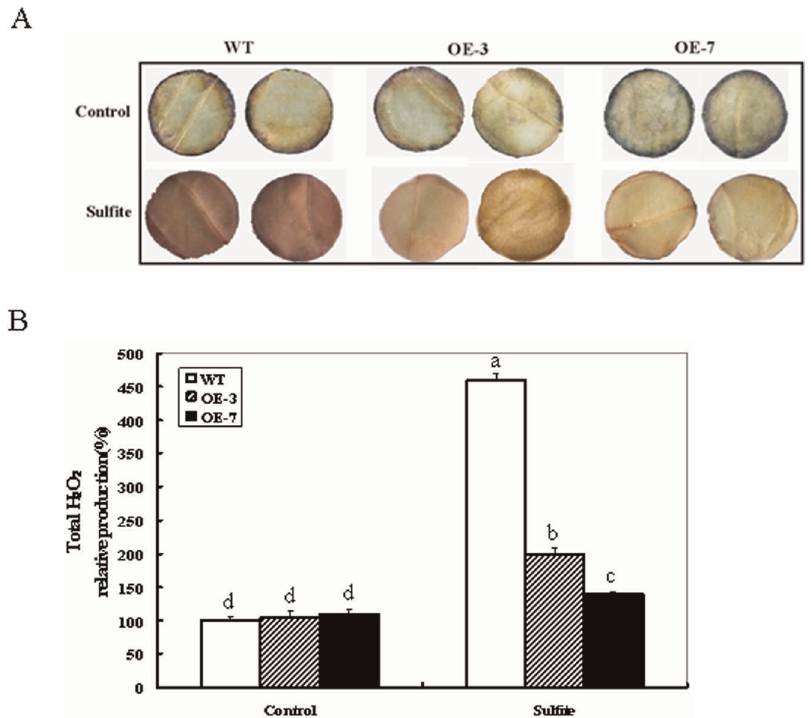
Figure 4. H 2 O 2 accumulation in leaf discs of wild-type and ZmSO over-expressing plants in response to sulfite exposure. (A) H 2 O 2 production in leaf discs of wild-type and OE plants treated with 5 mM Na 2 SO 3 was visualized by staining with 3, 3 9 -diaminobenzidine (DAB). The leaf discs were treated for 16 h, and were subsequently stained with DAB as described in the experimental procedures. (B) Relative total H 2 O 2 production was quantified in leaf discs from two independent experiments. Error bars indicate SE (n=10). The lower case letters (a, b, c, d) indicate P , 0.05 for the differences within treatment between ecotypes.